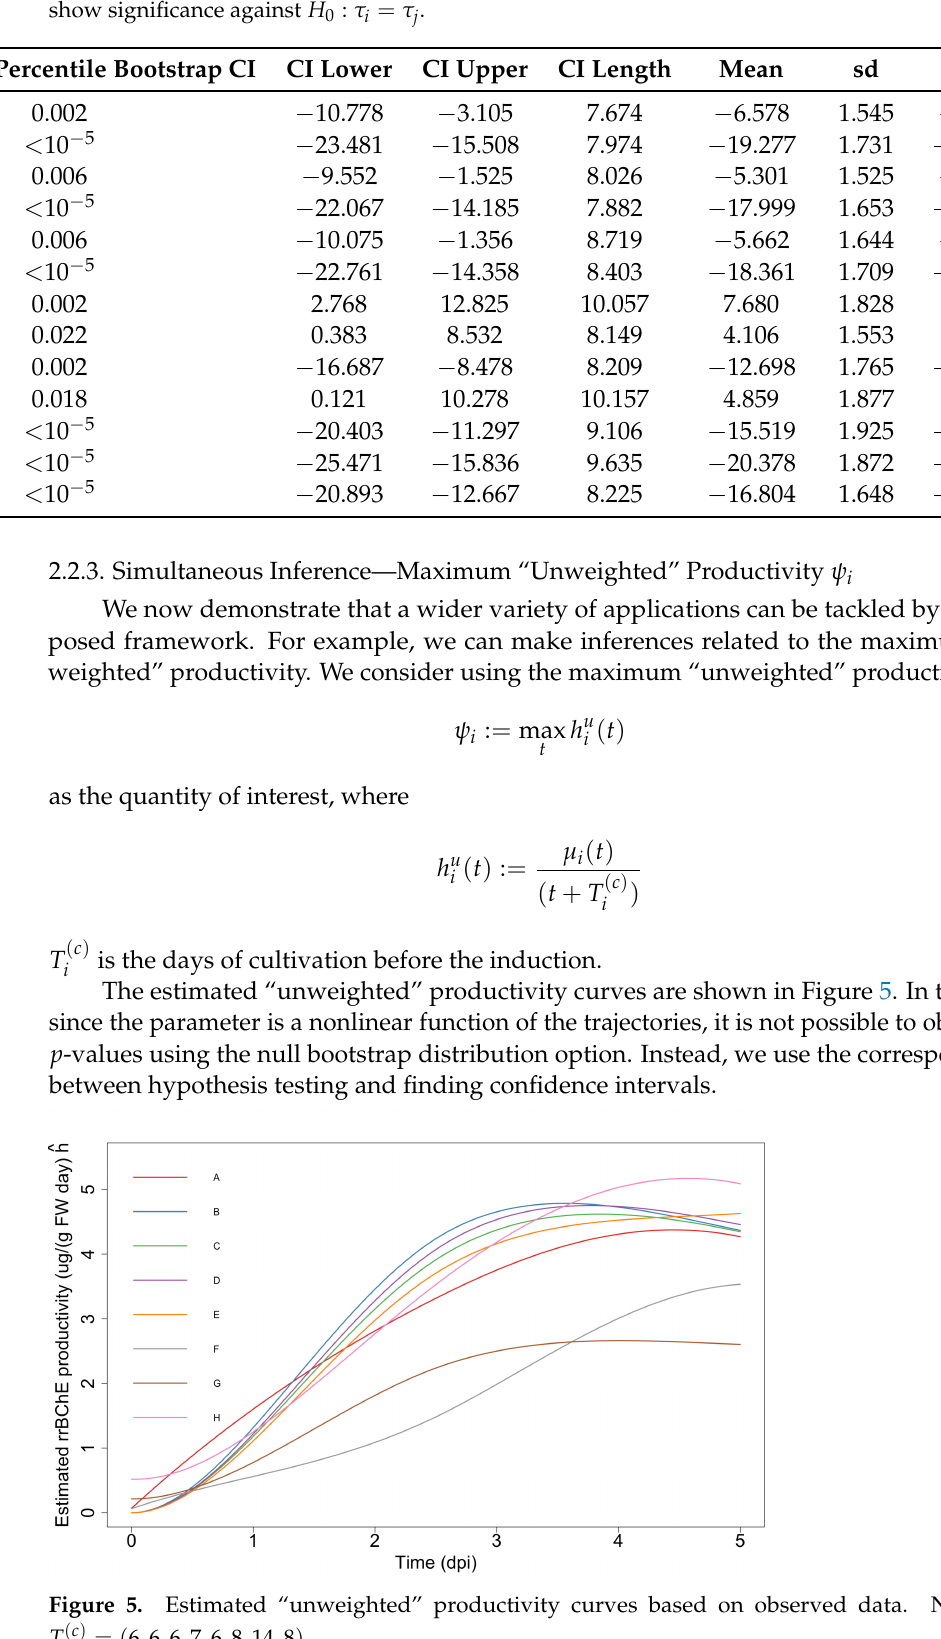
Table 3. Using parametric bootstrap: False coverage-statement rate (FCR)—Adjusted BH-Selected CIs for selected parameters indicated by the percentile bootstrap CI; All confidence intervals above show significance against H 0 : τ i = τ j .